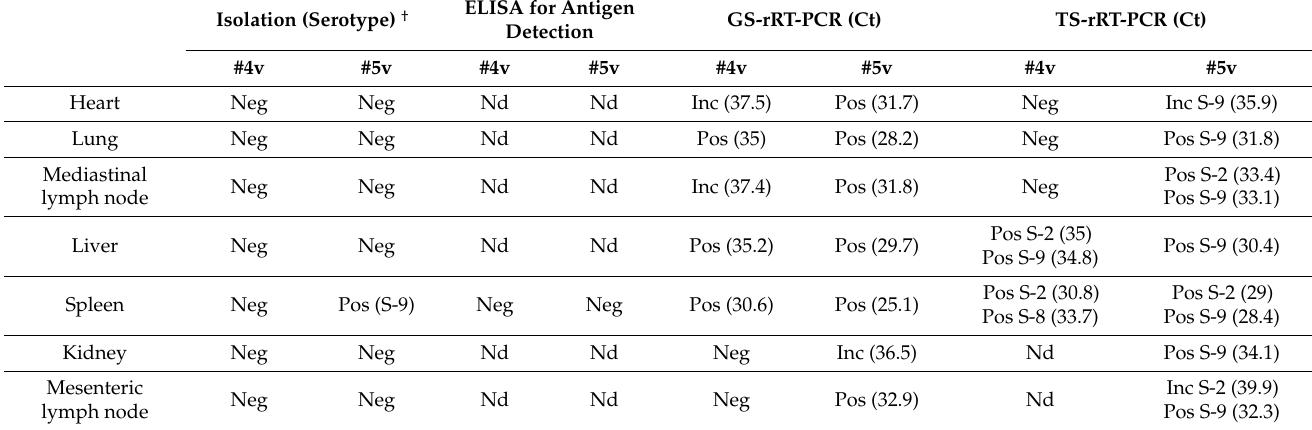
Table 6. Comparative AHSV detection in organs of vaccinated horses (#4v and